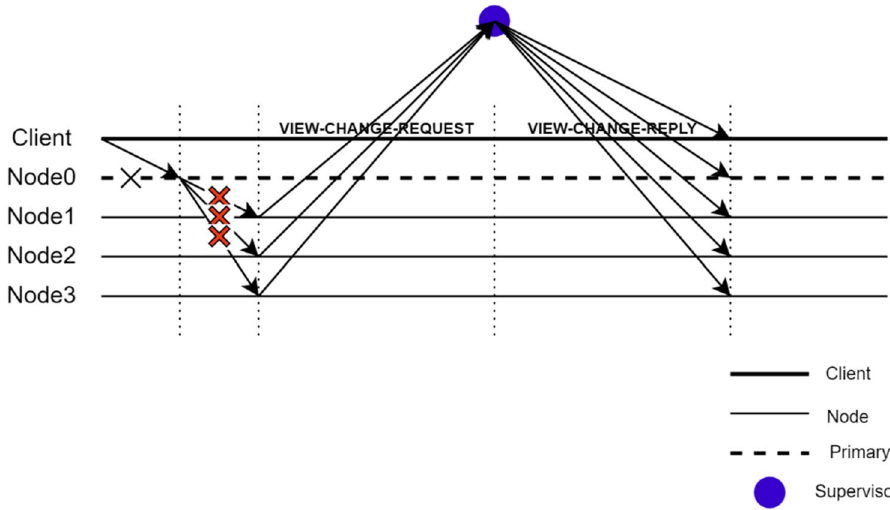
Figure 6. Intrashard view change flowchart.